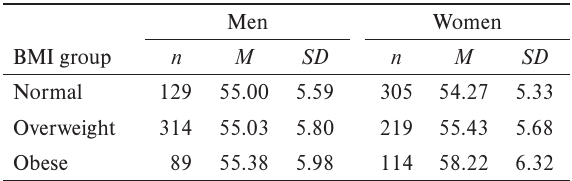
Age characteristics of men and women according to